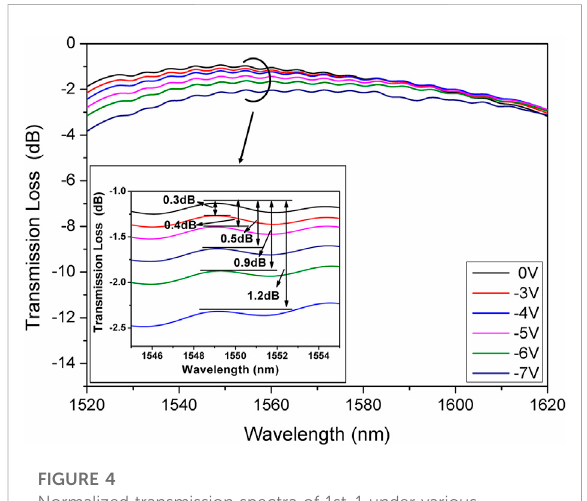
FIGURE 4 Normalized transmission spectra of 1st-1 under various reversed voltages. The inset fi gure shows the increasing loss at various reversed voltages.